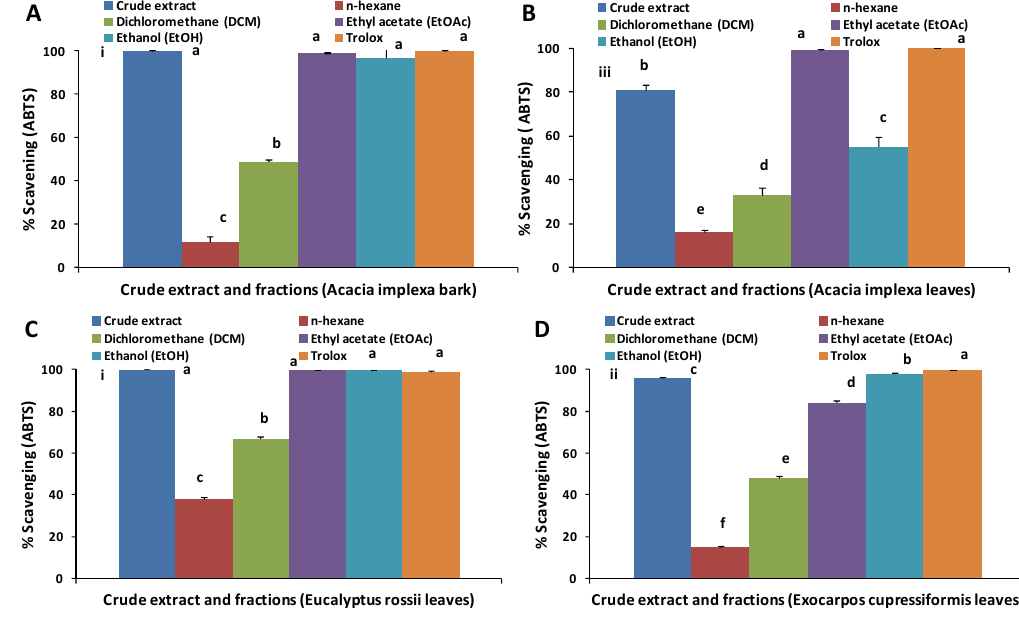
Figure 1. Radical scavenging activity for crude extract and fractions of: ( A ) A. implexa bark, ( B ) A. implexa leaves, ( C ) E. rossii leaves and ( D ) E. cupressiformis leaves. Different letters (a–f) in crude extract and fractions of same species show significant difference at p < 0.05. Different small Roman numerals (i–iii) show significant difference at p < 0.05 for crude extracts of different species. Results are presented as mean ± standard deviation (n = 3), and statistically significant difference was determined by one-way ANOVA and Tukey’s HSD post hoc